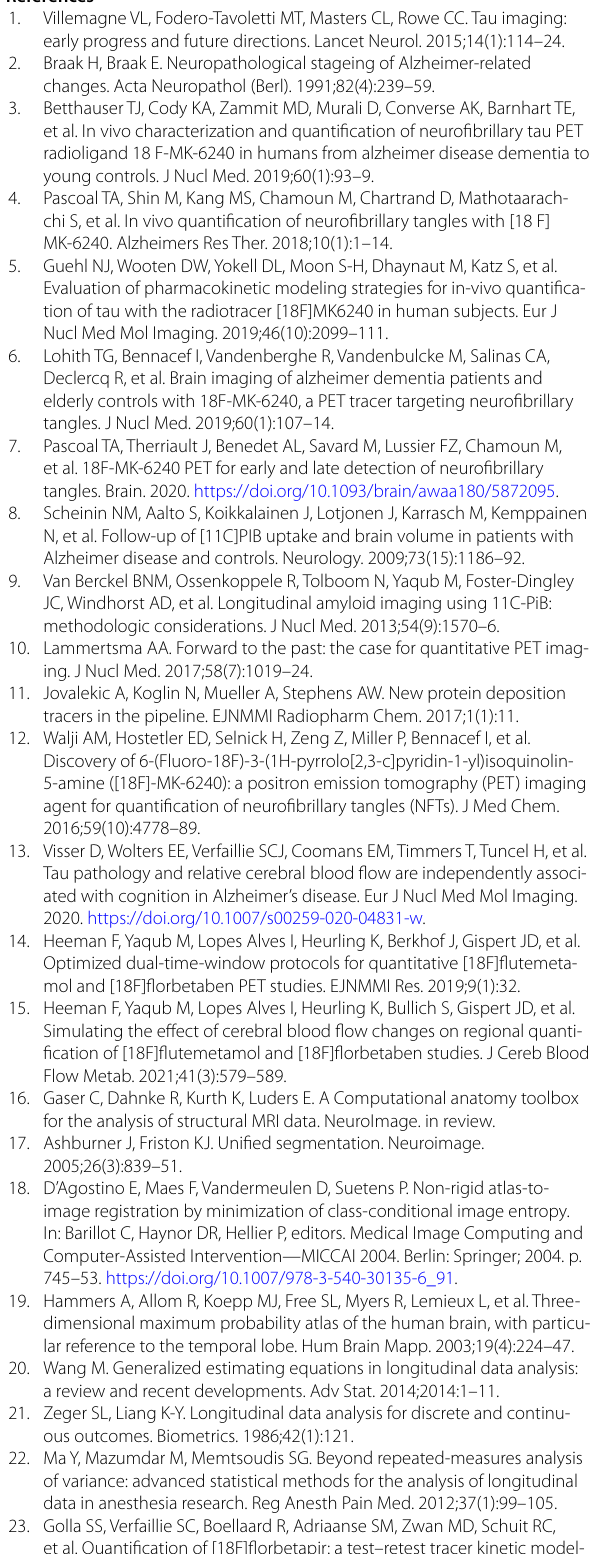
DTW protocol non-compliance; pooling target regions. Table S12: Bias on Reference Logan DVR from DTW protocol non-compliance. Table S13: Bias on SUVR90 due to perfusion changes with constant R1; pooling target regions. Table S14: Bias on SUVR90 due to perfusion changes with constant R1. Table S15: Bias on SUVR90 due to perfusion changes with variable R1; pooling target regions. Table S16: Bias on SUVR90 due to perfusion changes with variable R1. Table S17: Bias on SUVR90 from scan- ning protocol non-compliance; pooling target regions. Table S18: Bias on SUVR90 from scanning protocol